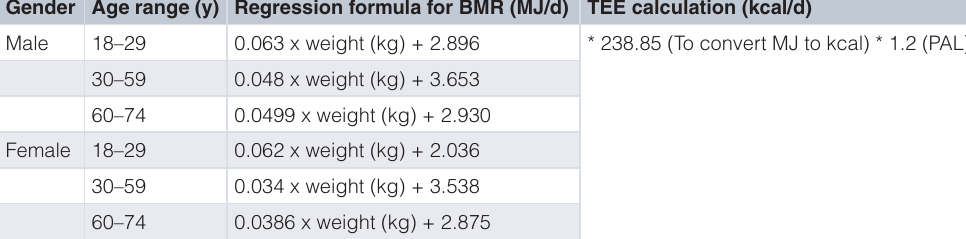
Table 1. Formula for calculating total energy expenditure (TEE) (kcal/day) using the Schofield equations and physical activity level